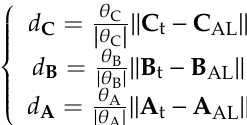
Figure 6. The movement of bolt 3 during facet alignment of the mirror unit: ( a ) Schematic drawing showing the geometric parameters of bolt 3 and their movements and ( b ) Diagram showing the maximum deflection angle β max = 2 β 1.